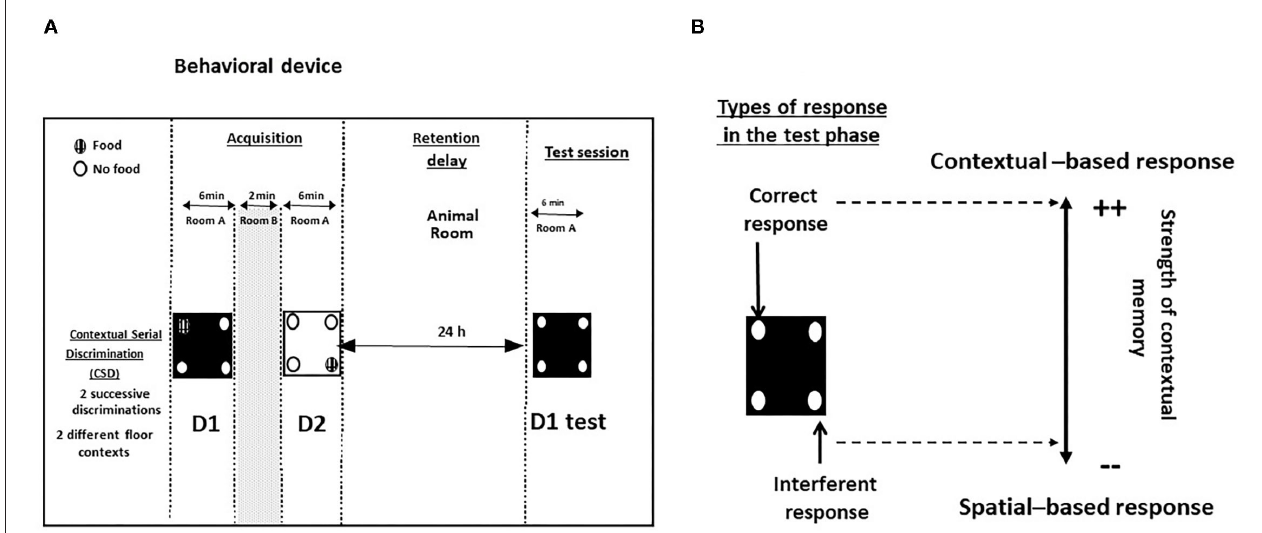
FIGURE 2 | (A) Behavioral device for the study of contextual memory in the CSD task; (B) Types of responses during the test phase. Correct responses: head-dips into the hole previously baited at D1 of the acquisition phase; interferent response: head-dips into the hole baited at D2 of the acquisition phase.